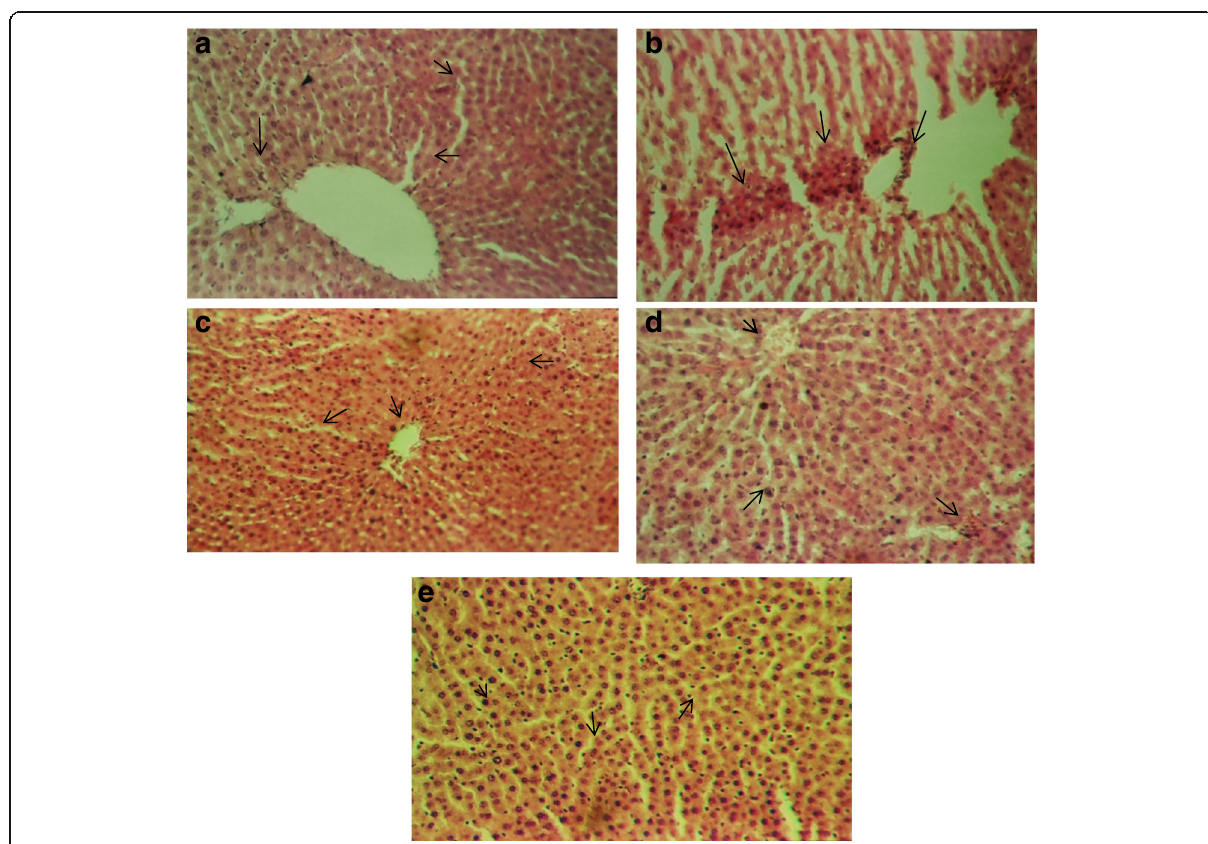
Fig. 2 Histopathological studies showing architecture of rats liver tissues in different pretreated groups. Magnification; 100X and 200X. a . Light micrograph of normal liver cells. b . Acetaminophen (AAP) treated rats. c . EW1 fraction of S. swartzii + AAP. d . EW2 fraction of S. swartzii +AAP. e . Liver cells of silymarin